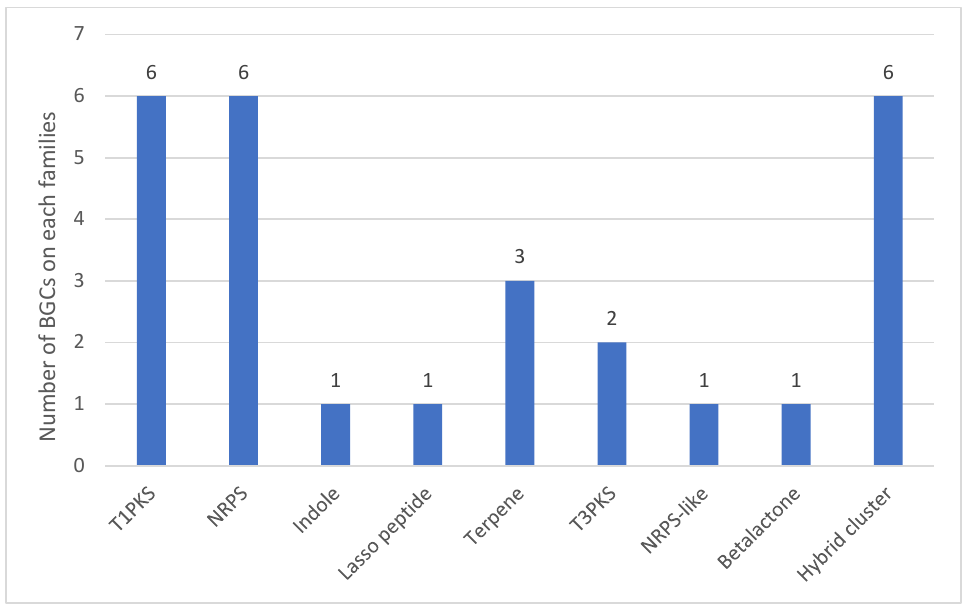
Figure 5. Identified biosynthesis gene clusters (BGCs) in C. keratinophilum (CBS 104.62). Abbreviations are as follows: (NRPS) non-ribosomal peptide synthetase clusters, (T1PKS) type 1 polyketide synthase clusters, (T3PKS) type 3 polyketide synthase clusters and (NRPS-like) non-ribosomal peptide synthetase-like cluster.